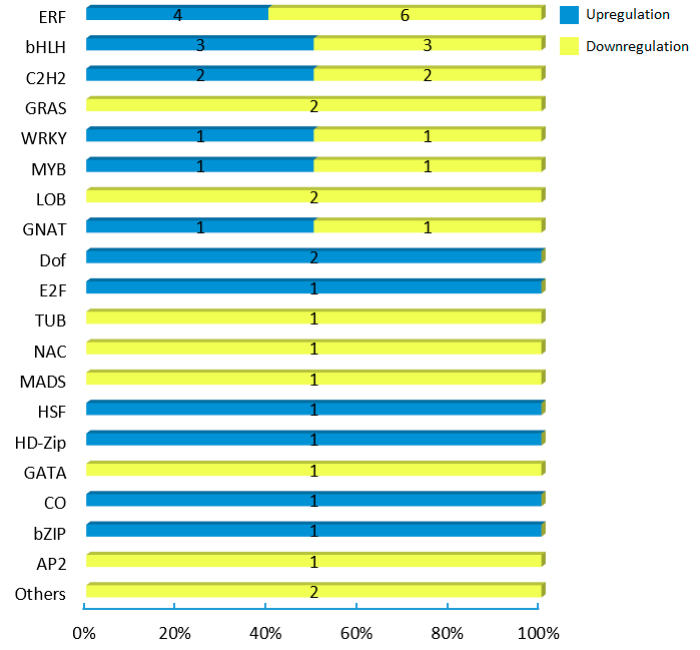
Figure 7. The distribution of putative target transcription factors of CsCBFs. Blue and yellow indicate significant up- and downregulation of the target genes, respectively. The numbers on bars represent the number of transcription factors, and the percentages on the horizontal axis represent the percentage of the number of transcription factors.